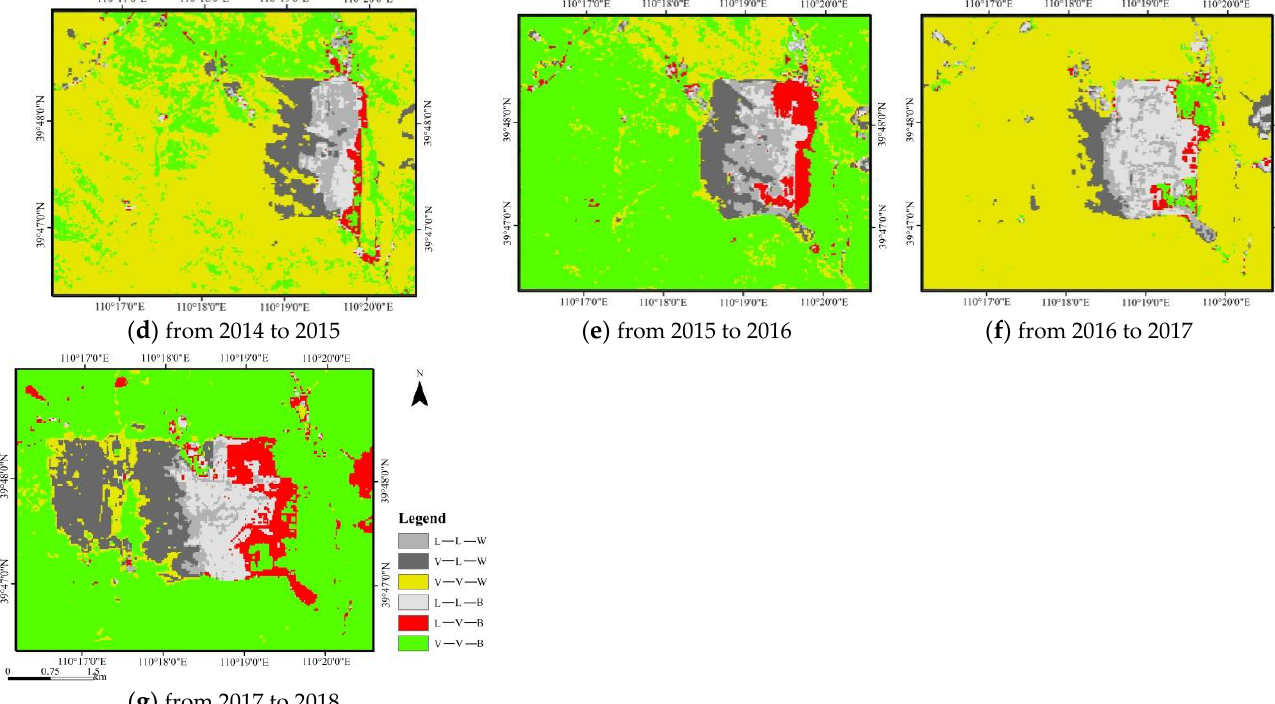
Figure 8. Change of land type in two adjacent years from 2011 to 2018 in the study region.